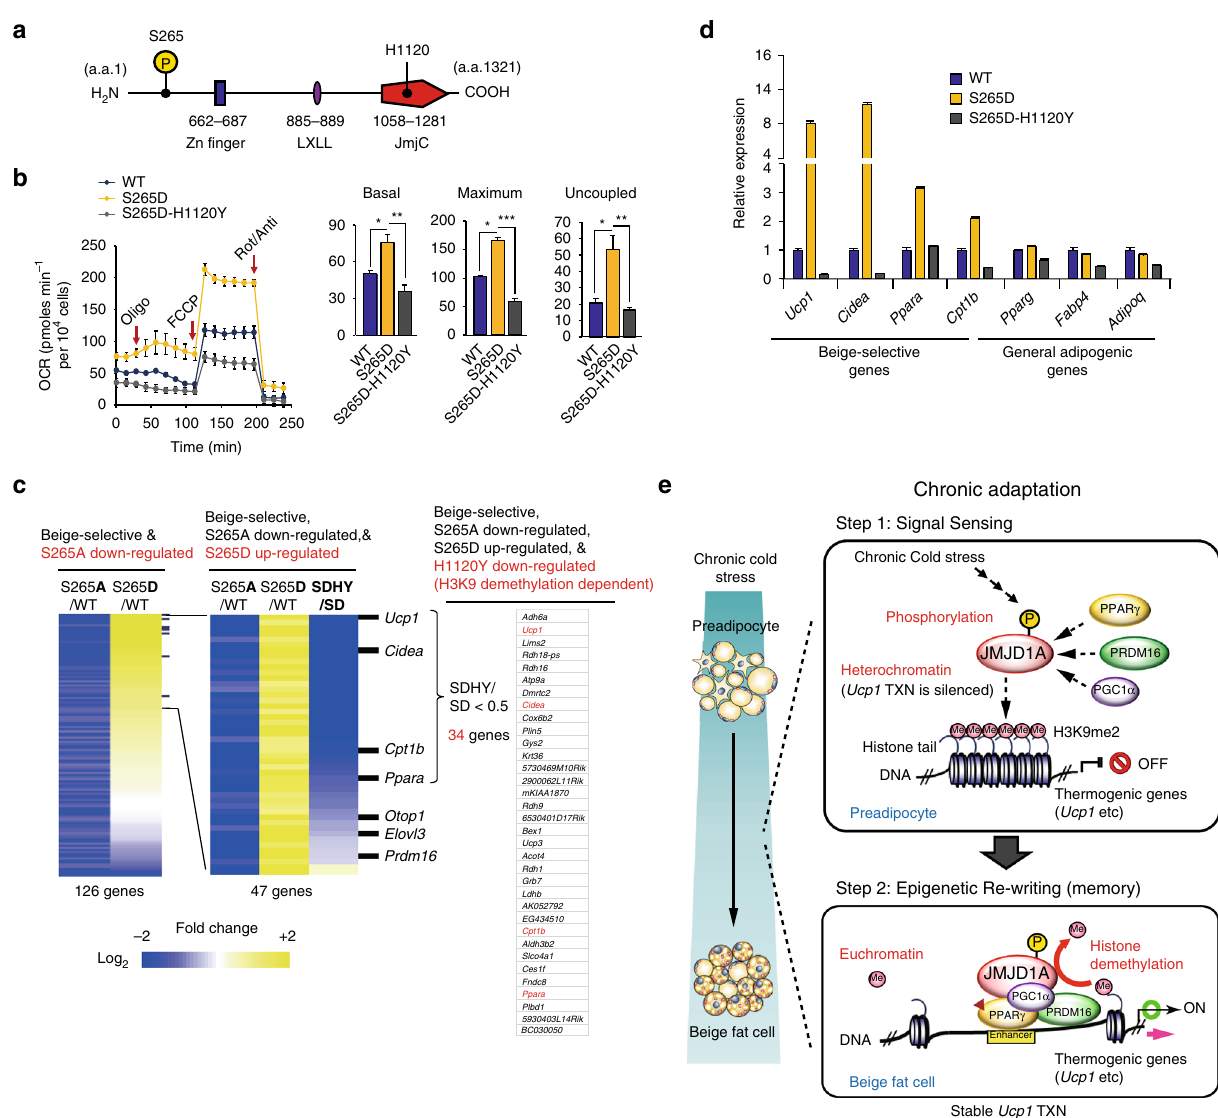
Fig. 6 Demethylation activity is pivotal for beige-selective gene inductions. a Schematic representation of the domain structure of human JMJD1A. Phosphorylation site at S265 and Fe(II) binding site at H1120 are shown. b OCR in im-scWATs stably expressing WT-hJMJD1A, S265D-hJMJD1A, or S265D-H1120Y-hJMJD1A treated sequentially with oligomycin (Oligo), FCCP, and rotenone/antimycin A (Rot/Anti) (left). Basal, maximum, and uncoupled respiration calculated from the left (right). Data are mean ± s.e.m. of three technical replicates in a representative experiment. Analysis of variance were performed, followed by Tukey ’ s post hoc comparison. * P < 0.05, ** P < 0.01, and *** P < 0.005 were considered statistically signi fi cant. c Heat map of mRNA levels determined by RNA-seq analysis of the indicated WT or mutant versions of hJMJD1A expressing im-scWATs. Changes are log 2 expression (FPKM) ratios. For reference, a color intensity scale is included. Thirty-four genes that are beige-selective, S265A downregulated, S265D upregulated, and H1120Y downregulated (H3K9 demethylation-dependent) are listed (right). d qPCR analysis con fi rming RNA-seq shown in c . Mean ± s.e.m. of three